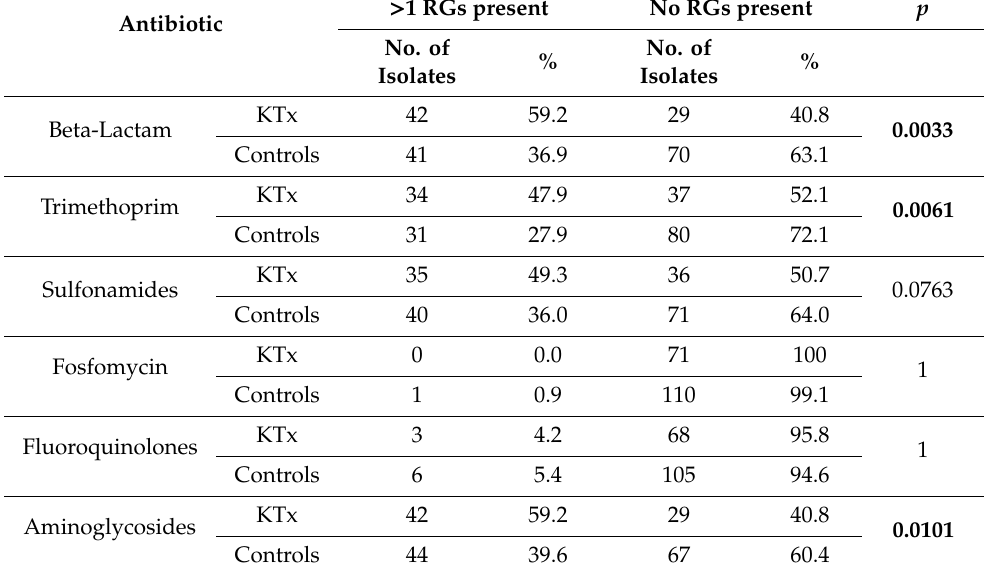
Table 4. Distribution of resistance genes (RGs) present in relation to KTx and control UPEC